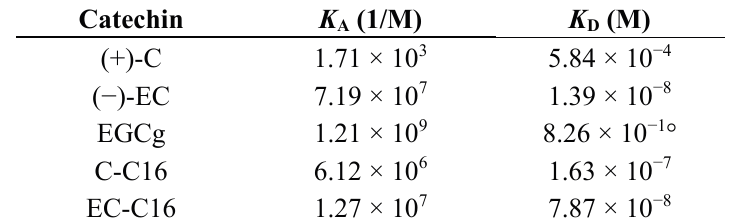
Figure 6. Binding between 3- O -acyl-catechins and lipid bilayer membrane. The sensorgrams indicated binding after injection of 130 μ L of 10 μ M catechins and their derivatives at a flow rate of 65 μ L/min. Table 1. Affinities for the interaction between catechins and lipid